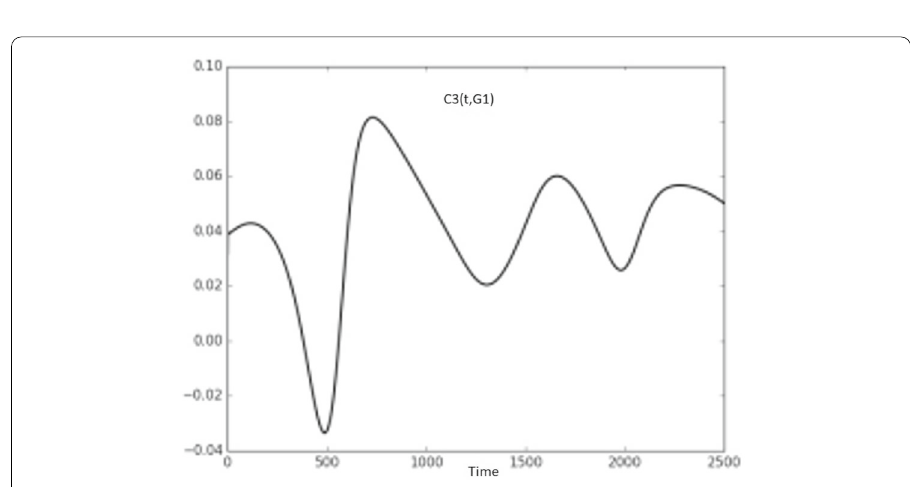
Fig. 31 The third temporal weight by the Galerkin projection upon (cid:9) : c 3 ( t,G 1 )